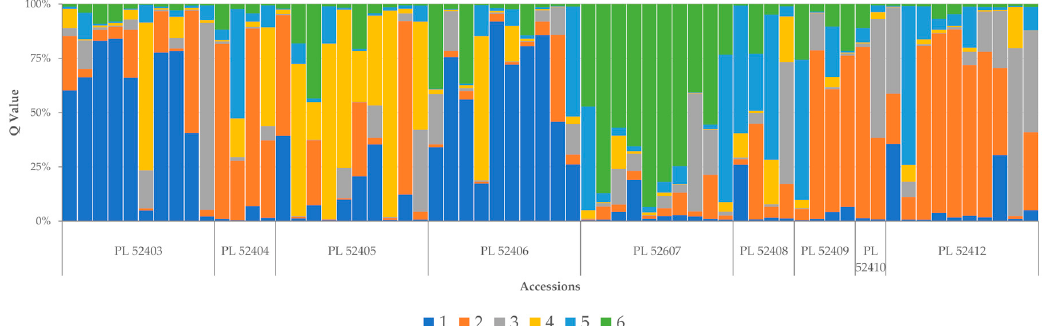
Figure 6. Q-plot of 50 000 burn-ins and 250 000 Markov Chain Monte Carlo generations of STRUCTURE software [33] with K = 6, where K is the number of ad hoc groups to be formed. Each vertical bar represents single plantlets. The length of the colored segment shows the estimated proportion of membership of that sample to each group. The analysis was performed for nine accessions of Avena macrostachya Bal. ex Cross. et Durieu based on sequence-related amplified polymorphism (SRAP) markers.